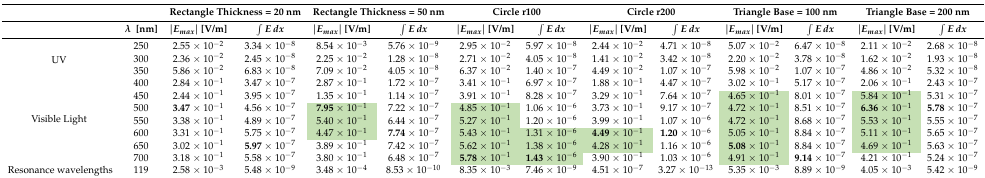
Table A4. Summary table of the results obtained for the aluminium nanostructures—Probe 1.